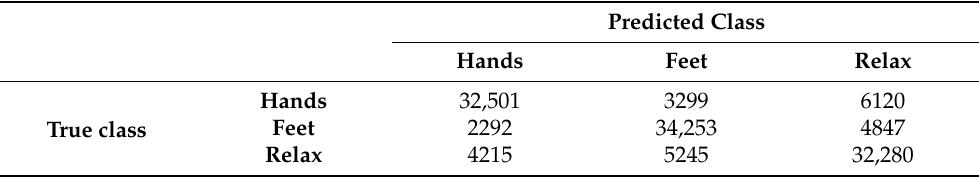
Table 6. CNN1 confusion matrix for 10 subjects and segment size of